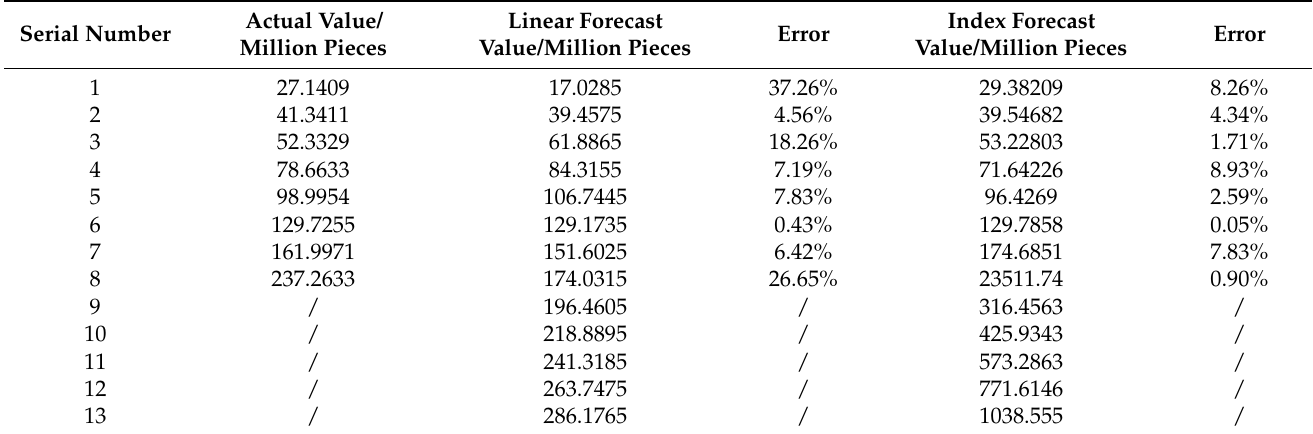
Table 2. Express business volume forecast.